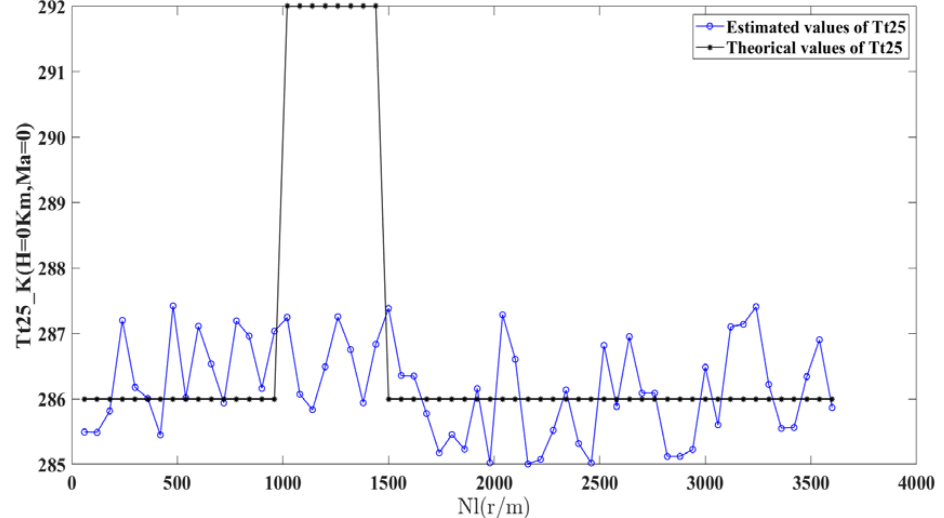
Figure 4. Estimations of T t25 by UKF.